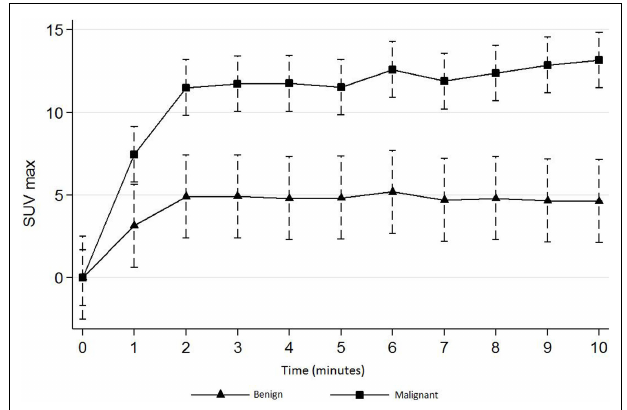
FIGURE 1 | Early dynamic curves (first 10min) for benign and malignant lesions acquired by mCT PET/CT ( n === 71) .